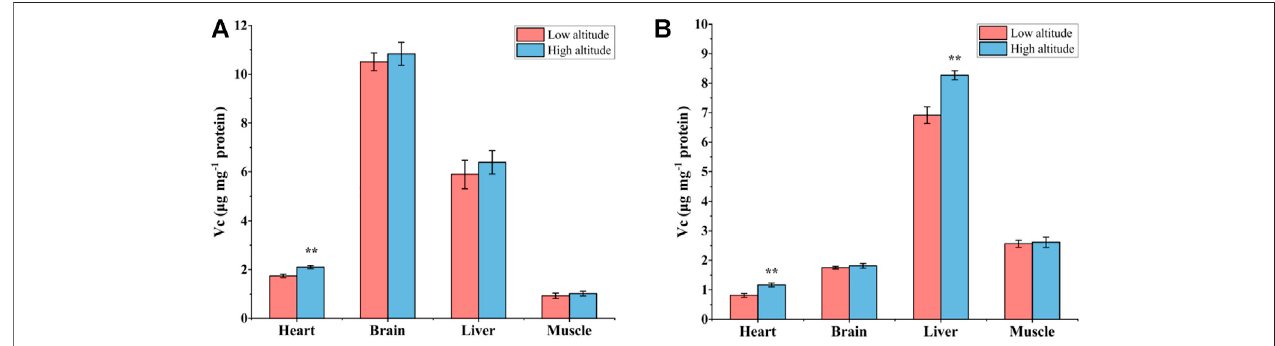
FIGURE6| ThecontentsofVitaminC(Vc)inheart,brain,liver,andmuscleoflow-altitudeandhigh-altitudeadult (A) and (B) juvenilefrogs.Valuesarepresentedas mean ± SEM ( n = 8). Asterisks (** p < 0.01) indicate signi fi cant differences between two altitudes.